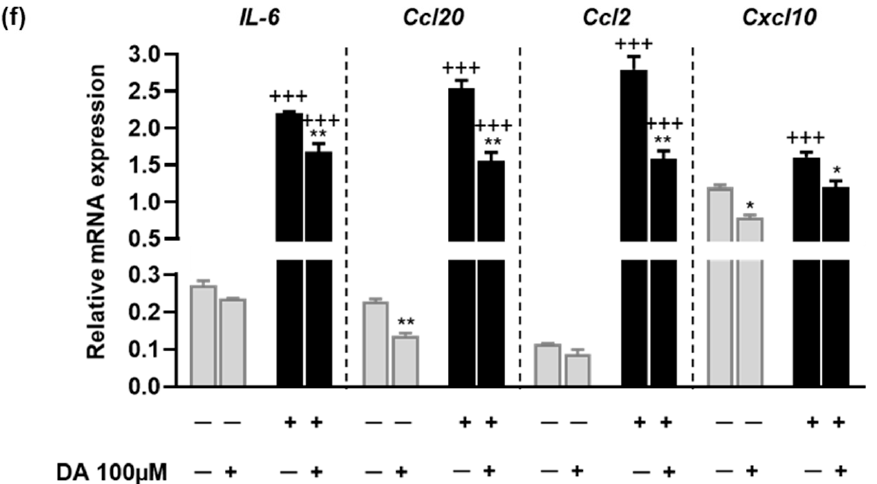
Figure 11. DA suppresses the inflammatory response by inhibiting nuclear localization of p-p65 (NF- κ B) and p-STAT3 and expression of their target genes in rat retinal capillary endothelial cells. ( a ) Representative Western blots and densitometric analysis of p-p65 and p-STAT3 in the ( b , c ) nuclear and ( d , e ) cytoplasmic fractions of rat retinal capillary endothelial cells treated with or without DA (25, 50, and 100 M) under the basal condition (none; grey line) or stimulation with IL-6, sIL-6R, and IL-17A. Results are presented as a fold change to control (basal condition without DA pretreatment) after normalizing with histone H3 in nuclear fractions and GAPHD in cytoplasmic fractions. ( f ) The mRNA expression of IL-6 , Ccl20 , Ccl2 , and Cxcl10 measured by qRT-PCR. GAPDH was used as an endogenous control. The data are the means ± SEM of three biological replicates. * p < 0.05, ** p < 0.01, and *** p < 0.001 by unpaired t -test analysis for comparisons between the DA treated group and the corresponding DA untreated group, and +++ p < 0.001 by unpaired t -test analysis for comparisons between the basal and cytokine-stimulated conditions with the corresponding concentration of